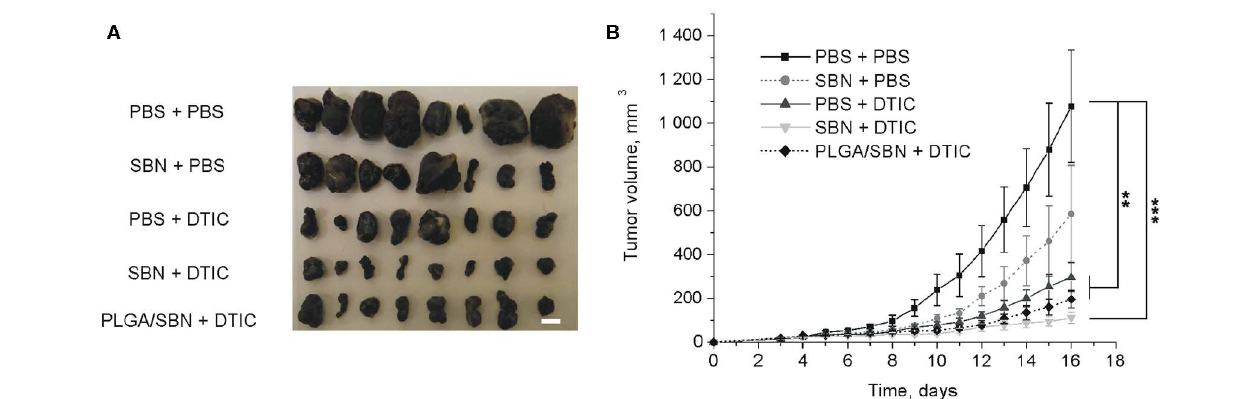
FIGURE 4 | The impact of SBN-containing hepatoprotective formulation on anticancer therapeutic effect of DTIC. (A) Images of excised B16F1 tumors from different groups of mice. Scale bar is 5mm. (B) Kinetics of tumor growth. Pre-treatments with PBS either SBN formulations were performed on the days 3, 6, and 9 after inoculation of cancer cells. Treatments with antineoplastic drug DTIC or PBS (in control groups) were made on the days 4, 7, and 10. All values are shown as means ± SEM. ** P < 0.01, *** P < 0.001 (one-way ANOVA followed by a post-hoc Tukey’s test).